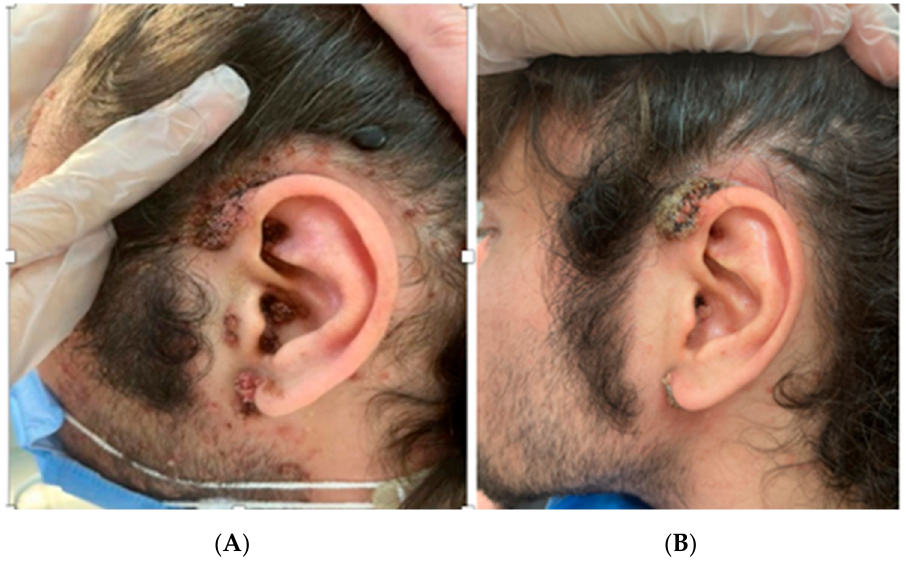
Figure 2. ( A ) Left auricular area before treatment. ( B ) Left auricular area after two sessions of PDT. Only a single session was needed to treat the facial warts (Figure 1B). Interestingly, little warts located on the untreated auricular area and on the scalp also disappeared without MAL gel application ( B ). The retro-auricular warts disappeared after only a single PDT session (Figure 3B). There was no recurrence of the disease nor any kind of skin dyschromia after a three-month follow-up. We then asked the patient to fill in the DLQI form again and obtained a score of 0. Upon consent of the patient, we performed C-PDT using the photosensitizing agent methyl aminolevulinate (METVIX ® cream, Galderma Medical Solutions), left the affected area under occlusion for three hours, and then illuminated the affected area with a red 630 nm light-emitting diode (LED) lamp (Aktilite CL128 ® , Galderma Uppsala, Sweden) set at 37 J/cm 2 for 8:30 min. The patient felt a very mild burning sensation that was relieved with a spray of water. Because of the high number of lesions in different areas, and in order to avoid too much discomfort, we decided to initially treat only lesions on the face.